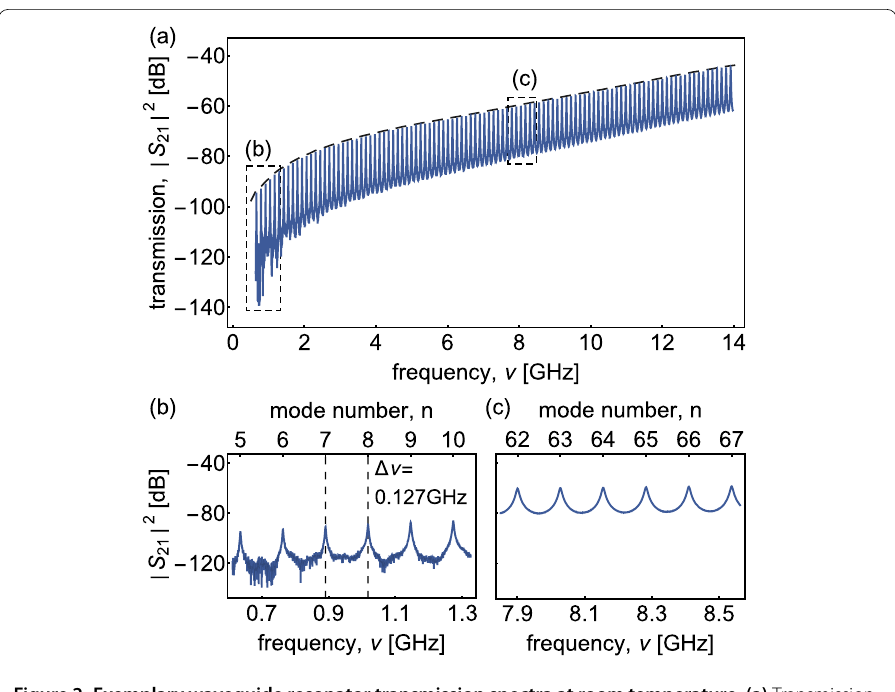
Figure 2 Exemplary waveguide resonator transmission spectra at room temperature. (a) Transmission coefficient | S 21 | 2 versus frequency ν for CC141Al at RT. The dashed line indicates the frequency-dependent insertion loss on resonance IL ( ν n ). | S 21 | 2 of (b) the first 6 measured modes and (c) 6 modes around 8 GHz as indicated by the dashed boxes in (a).